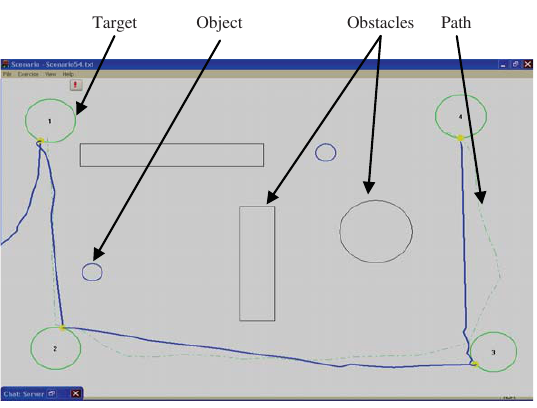
Fig. 8. PLEIA multi-platform